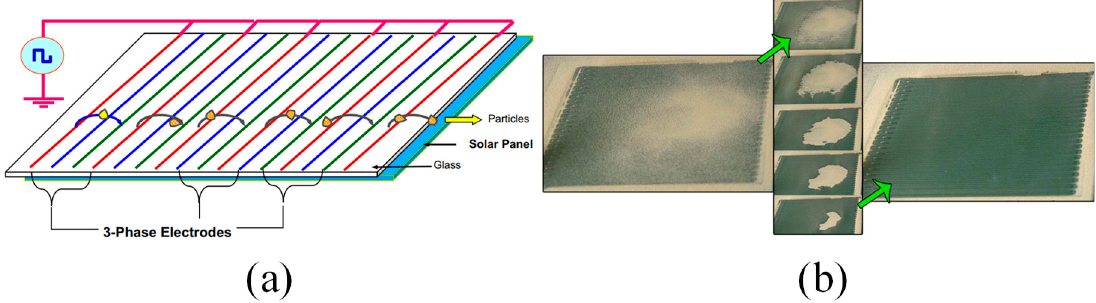
Figure 15. ( a ) Schematic view of a typical electrodynamic screen (EDS) design. Reproduced with permission from [144], published by Elsevier, 2013. ( b ) Sequential images of the dust removal processes on top of the EDS panel by electrodynamic force. Reproduced with permission from [143], published by IEEE, 2013.